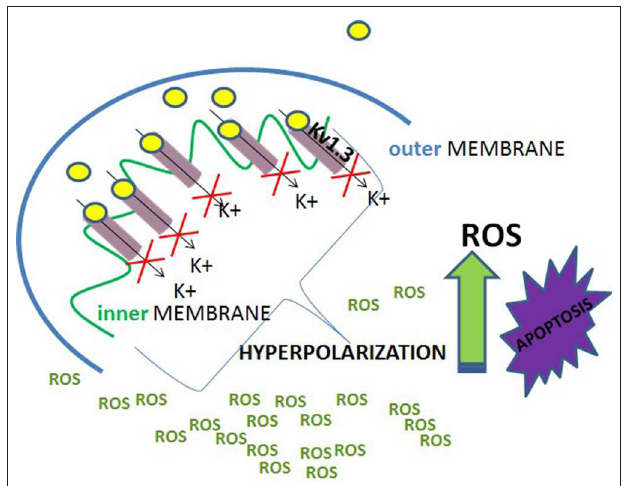
FIGURE 7 | A scheme of selective activation of the mitochondrial pathway of apoptosis of Kv1.3 channels’ expressing cancer cells.